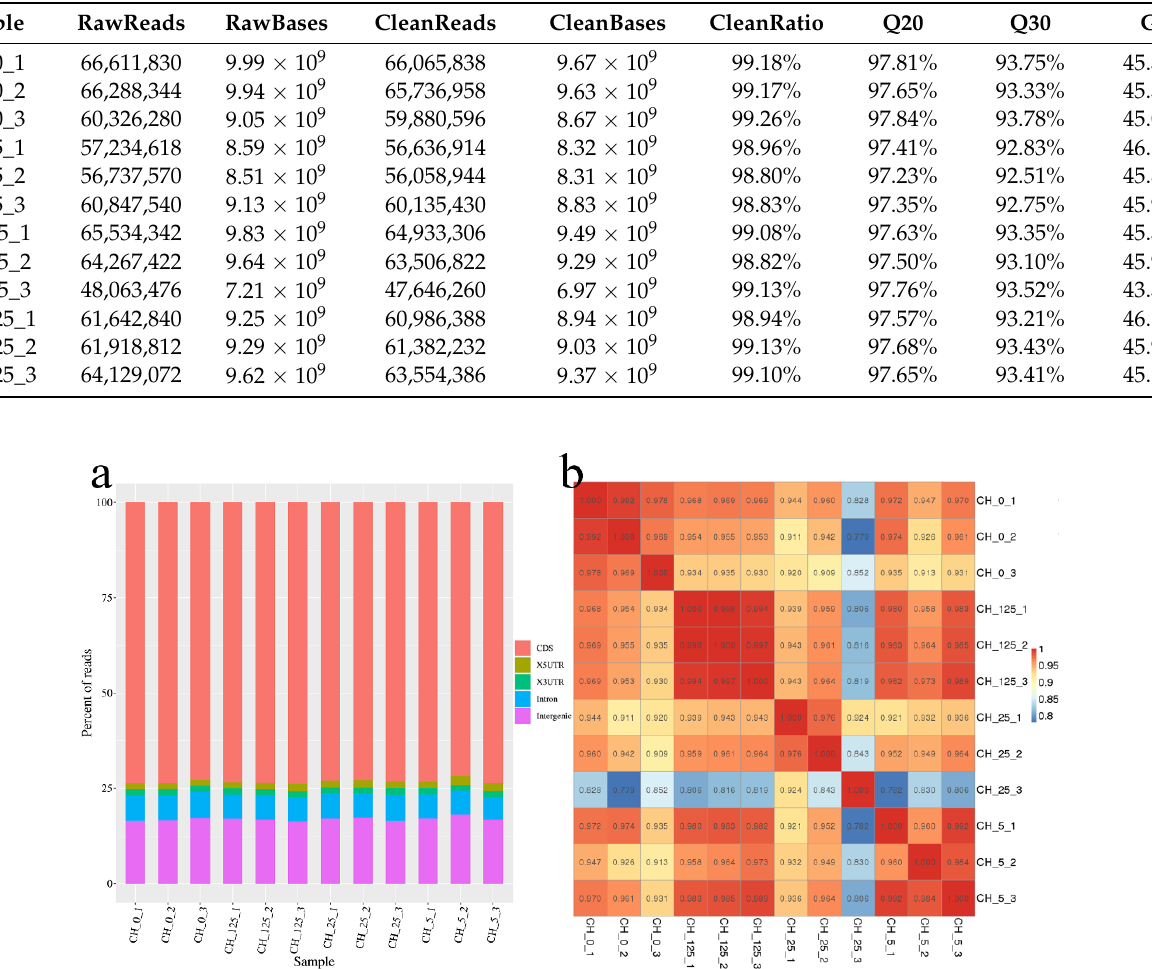
Table 1. The statistics of reads before and after filtering.